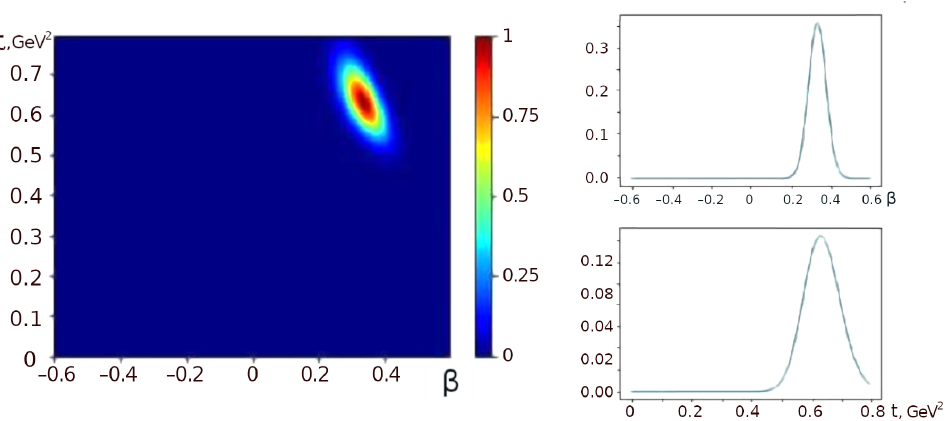
Figure 9. A posterior distribution of model parameters ( β , t ) for pp collisions at 2.36 TeV energy ( left ) and its projections ( right ).